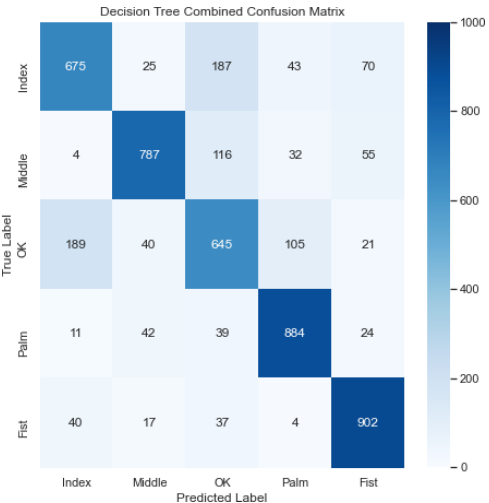
Figure 8. Combined confusion matrix for decision tree model. Rows represent actual classes; columns represent predicted classes. Dark blue shading indicates a large value; light blue shading indicates a small value. The average accuracy, precision, recall, and F 1 score for this model were 91.18%, 77.95%, 77.96%, and 77.85%, respectively.